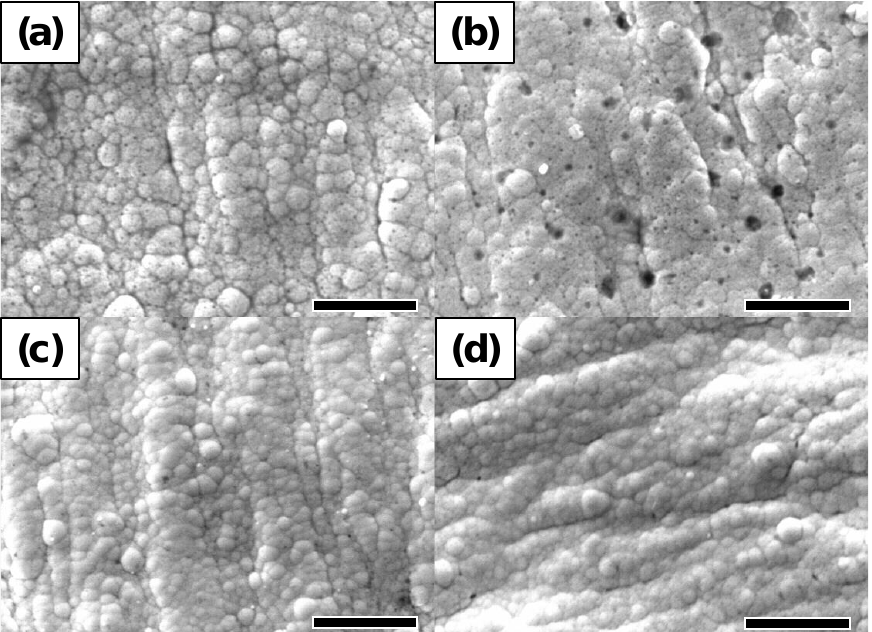
Figure 5. SEM images for Au coated PCBs with different plating methods in the passage of time in acidic solution. A DC electroplating method after ( a ) 0 h, ( b ) 24 h and a pulse electroplating method after ( c ) 0 h, ( d ) 24 h. Scale bar is 5 μm.